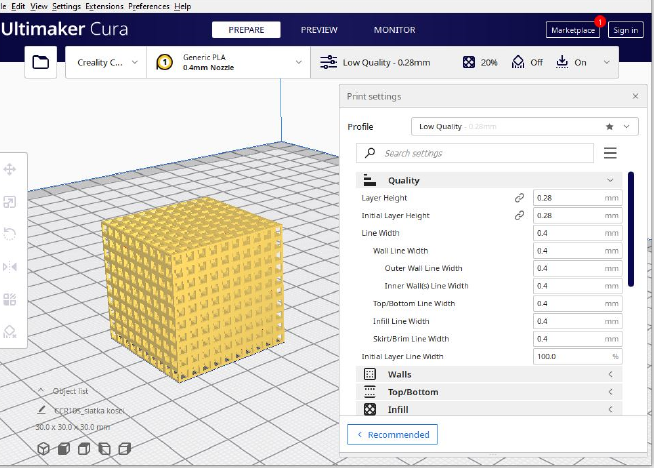
Figure 5. A model of a 30 mm × 30 mm × 30 mm lattice during preprocessing in Ultimaker Cura. The software allows the user to adjust printing parameters for the desired effect.